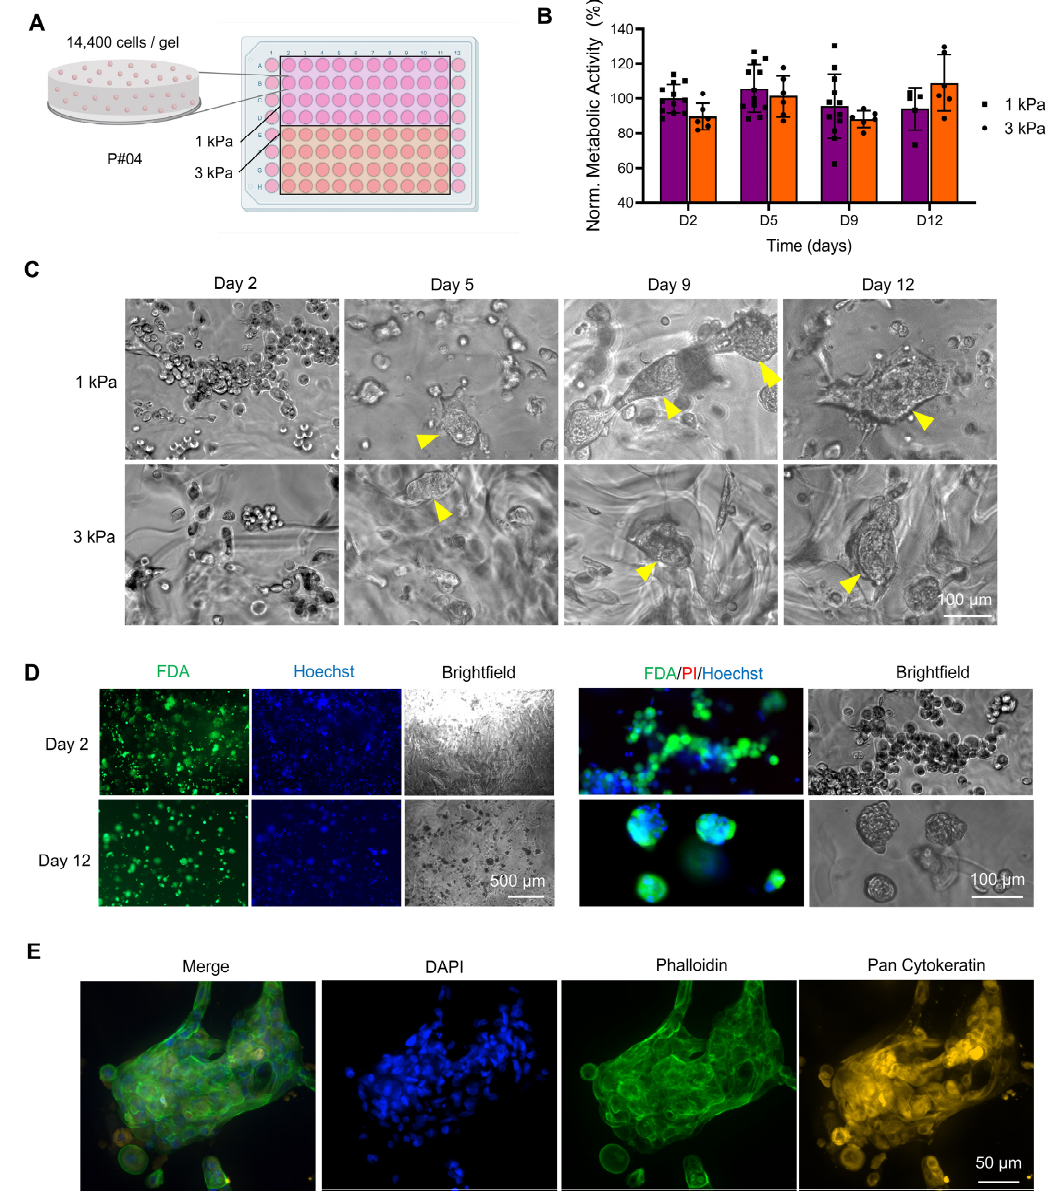
Figure 3. Effect of PEG-based hydrogel stiffness on growth and viability of breast cancer patient- derived organoids (P#04F). ( A ) Schematic of bioprinted well-plate conditions, comparing 1 and 3 kPa PEG hydrogels functionalized with RGD + GFOGER + DYIGSR. ( B ) Metabolic activity over time, normalized to the 1 kPa group at Day 2. Means ± SD shown, n = 6–12 technical replicates. No statistical differences. ( C ) Brightfield images of cells in hydrogels over time, showing organoid formation (yellow arrows) after 5 days of culture for both stiffnesses. ( D ) Epifluorescence images of FDA/PI/Hoechst staining and corresponding brightfield microscopy images, showing live cells (green), dead cells (red), cell nuclei (blue), and overall morphology, respectively, at 2 and 12 days post-bioprinting for 3 kPa PEG hydrogels. ( E ) Confocal fluorescence images of immunofluorescence for cell nuclei (blue), cytokeratin (Pan-CK, yellow), F-actin (green) after 12 days of culture for 3 kPa